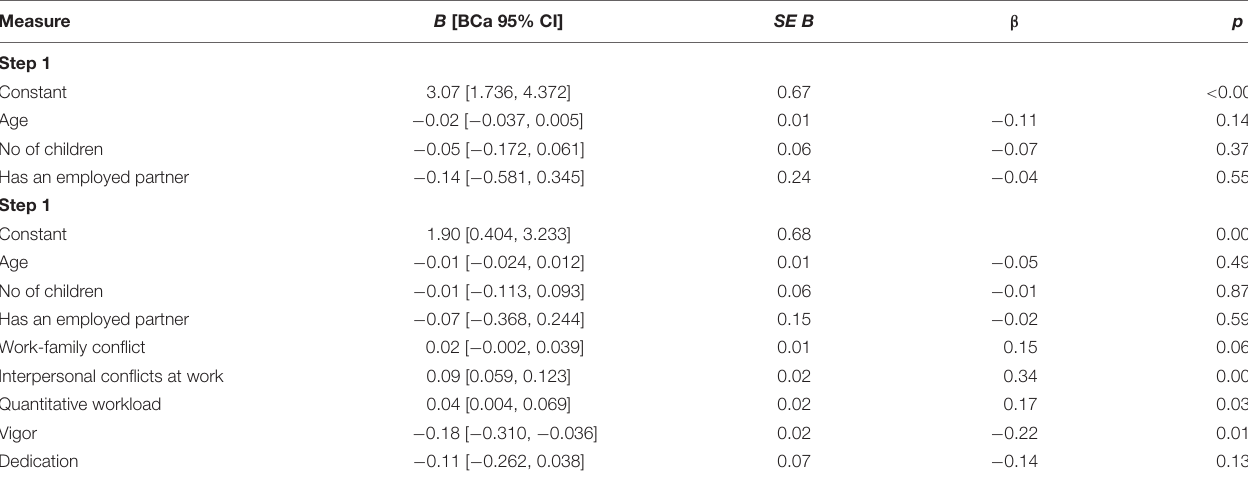
TABLE 3 | Linear model of antecedents of an intention to leave the present workplace, with 95% Bias corrected and accelerated (BCa) confidence intervals (CIs) in parentheses, among Polish nurses ( N = 188). Measure